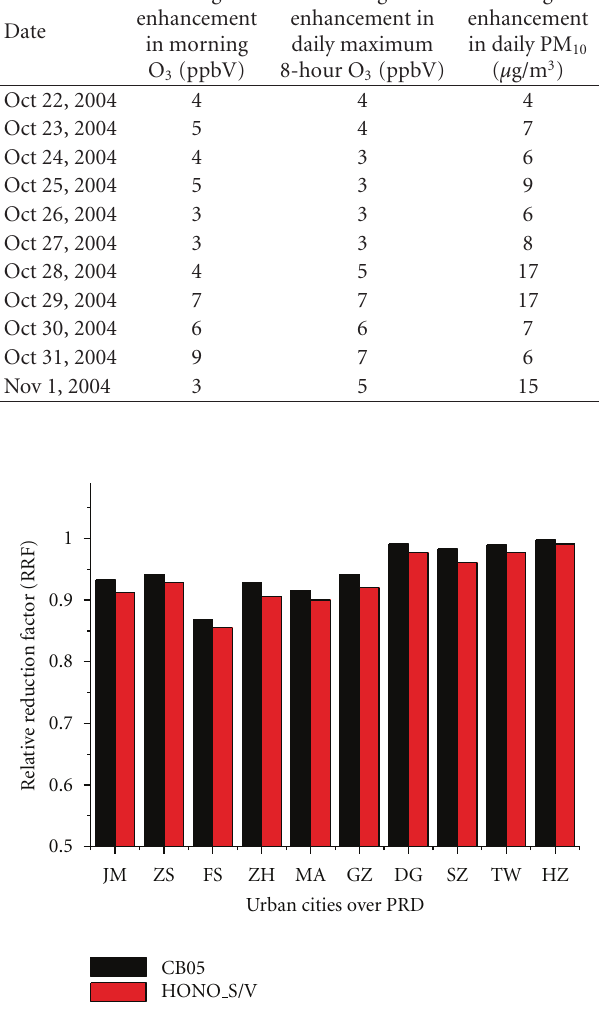
Figure 10: Average relative reduction factor (RRF) for ozone is due to 25% VOC emission reduction using simulation cases CB05 and HONO S/V . The major cities over PRD are ordered by longitude from west to east (see Figure 1): JM: Jiangmen, ZS: Zhongshan,